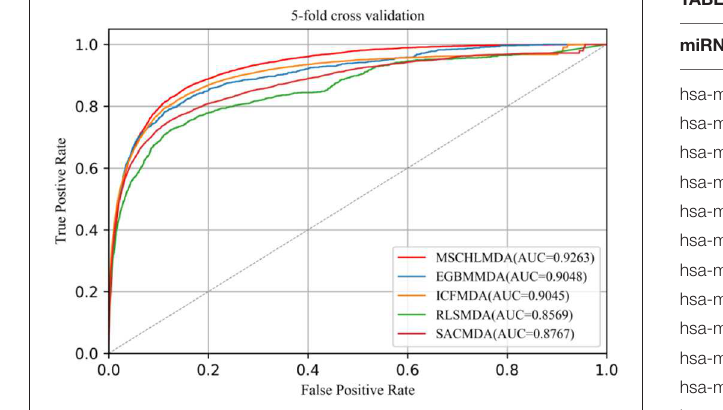
FIGURE 6 | AUC of 5-fold cross validation compared with EGBMMDA, ICFMDA, SACMDA, and RLSMDA.